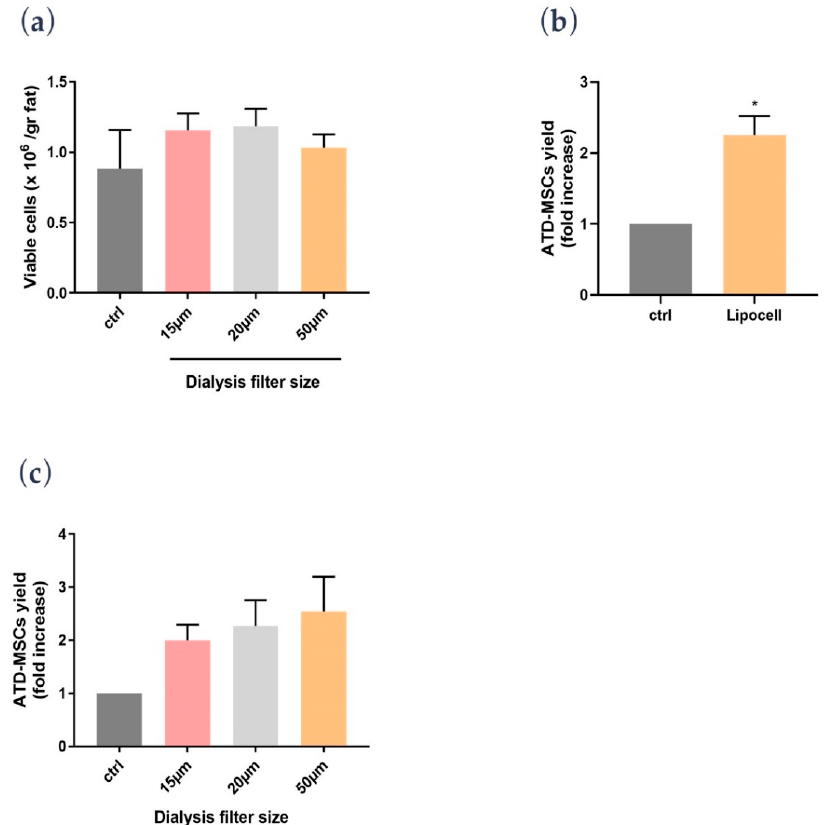
Figure 1. ( a ) The number of viable cells on the adipose tissue weight (samples, n = 9) was comparable among the different filters and control. ( b ) Adipose tissue-derived mesenchymal stem cell (ATD-MSC) percentage from Lipocell-processed adipose tissue (Lipocell, n = 27) increased compared to the relative untreated control from the same donor, * p < 0.01. ( c ) ATD-MSC yield of samples from different filter sizes (n = 9).